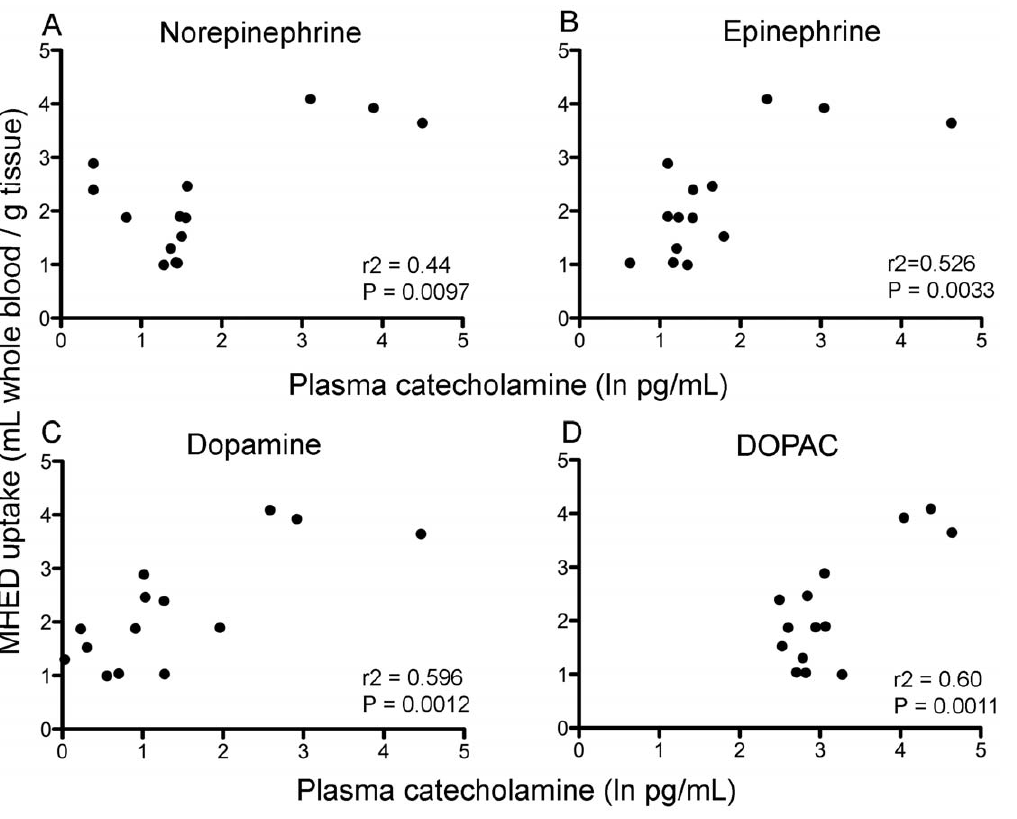
Figure 5. Correlation between plasma catecholamine levels and MHED uptake. Significant correlations between normalized blood catecholamine concentrations and left ventricle myocardium MHED uptake. A, Norepinephrine. B, Epinephrine. C, Dopamine. D,